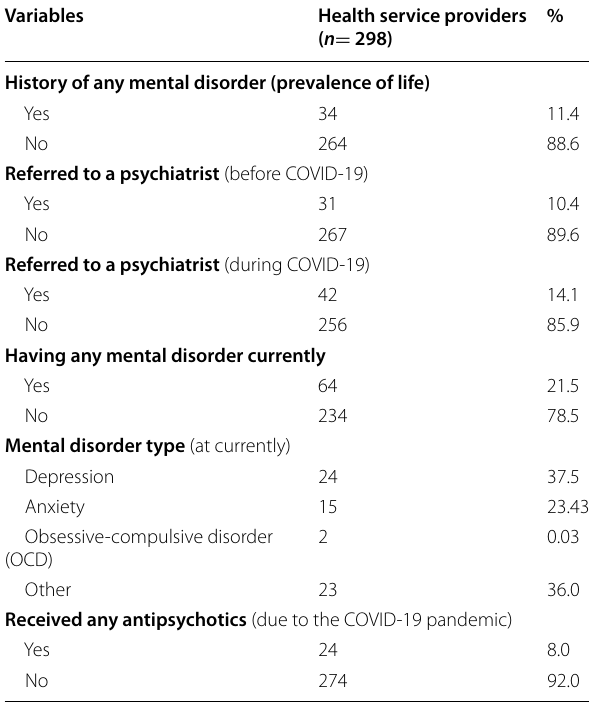
Table 2 Distribution of mental disorder before and during the COVID-19 pandemic among HSPs at Tabriz University of Medical Sciences